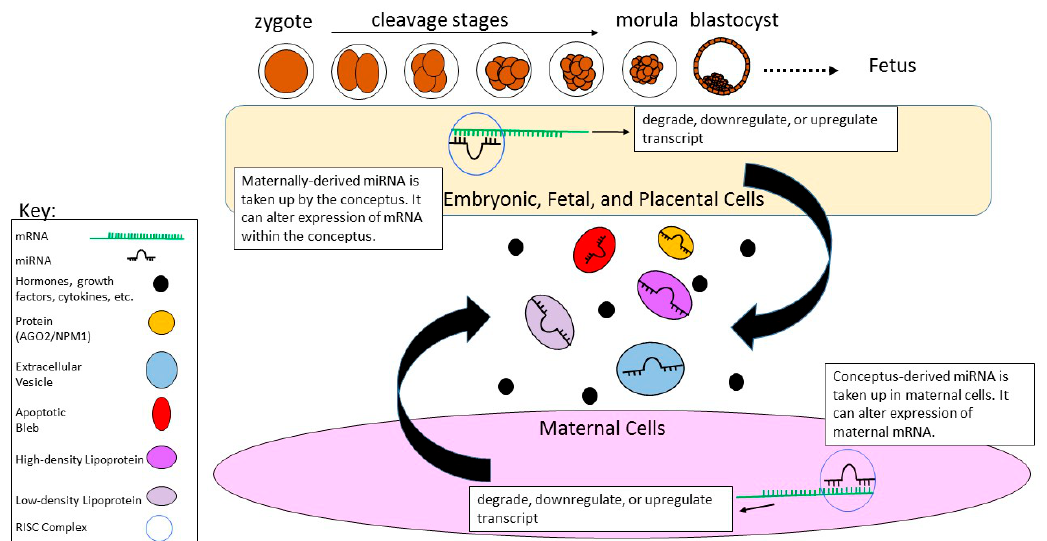
Figure 3. Schematic representation of miRNA crosstalk between a conceptus and mother. miRNAs have the potential to be transferred between maternal cells (represented as endometrium) and conceptus through various types of vehicles. These vehicles can be proteins (Argonaute 2 (AGO2) and Nucleophosmin 1 (NPM1)), extracellular vesicles, apoptotic blebs, high-density lipoproteins, and low-density lipoproteins. Upon delivery to either the mother or conceptus, the miRNA becomes bound to a RNA-induced silencing complex (RISC) and pairs to a complementary target mRNA. The target mRNA is then degraded, downregulated, or upregulated. This crosstalk can occur through direct cell–cell contact or miRNAs can be circulated and transferred in fluids, such as uterine fluid.